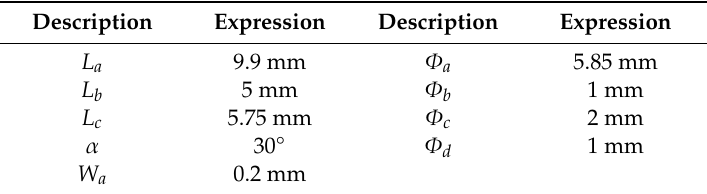
Figure 2. Cross sectional view of the theoretical model, indicating its geometric dimensions, inlet and outlet of the flows. Φ indicates diameter, L indicates length, and W indicates width. Table 1. Constants adopted in the theoretical model.